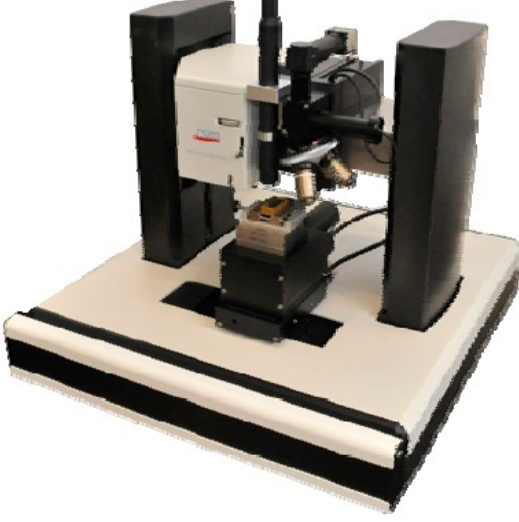
Figure 2. A micro-indentation tester.